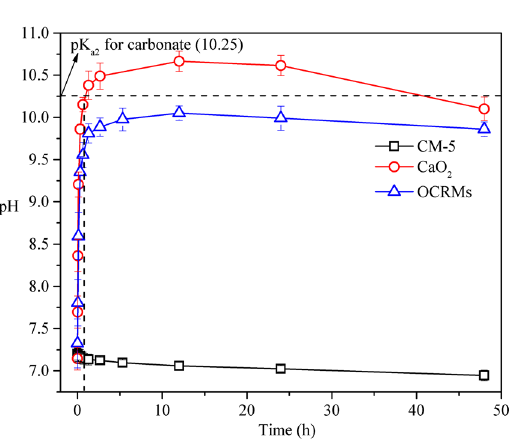
Figure 4. Phosphate removal by oxygen controlled-release microspheres (OCRMs) and CaO 2 with time in the experiment. The initial phosphate concentration is around 0.3 mg/L (pH 7.2). Both OCRMs and CaO 2 have the same available CaO 2 content.